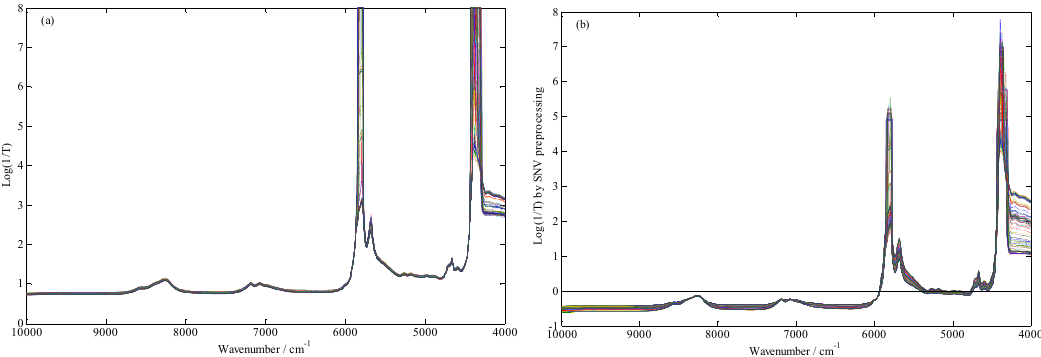
Figure 4. The original FT-NIR spectra ( a ) and the standard normal variate (SNV) preprocessing FT-NIR spectra ( b ) of all adulterated EVOO samples.